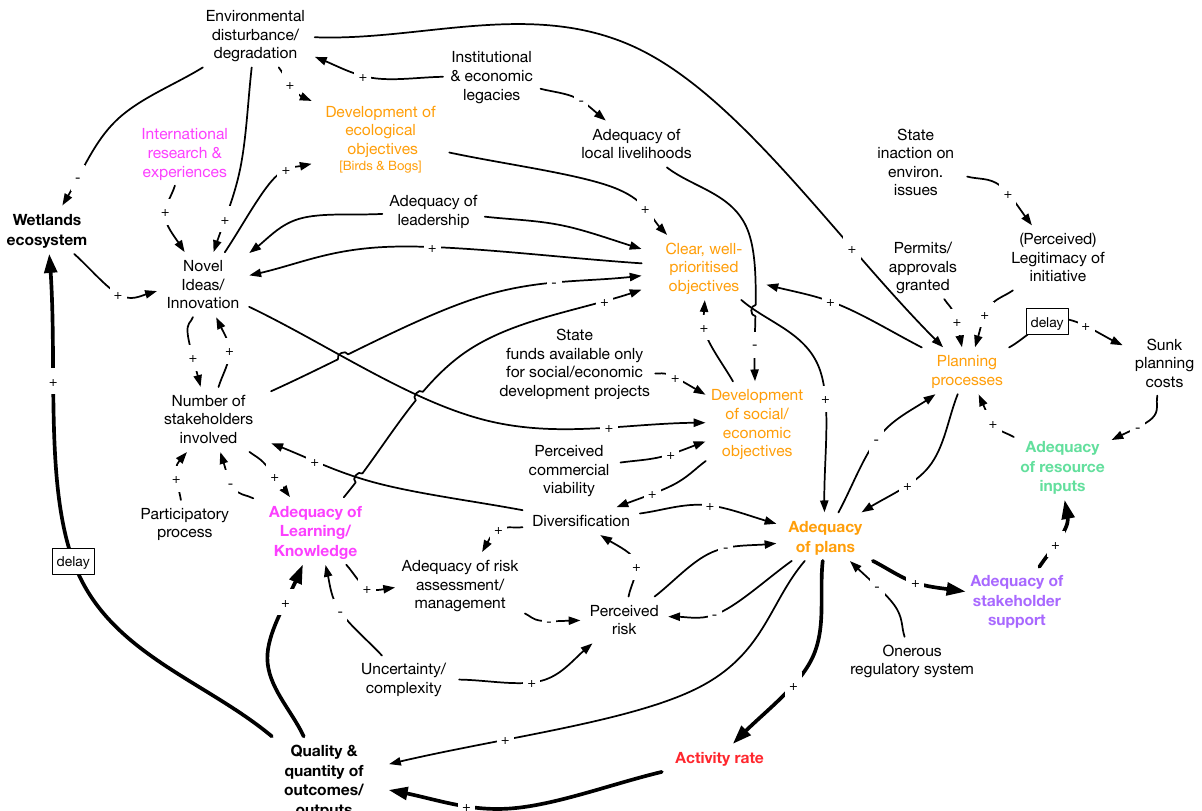
Figure 5 (from main paper). Sub-model unpacking the causal dynamics influencing the Adequacy of plans for wetland restoration initiatives in Belarus. Core processes are in bold. Coloured non-bolded variables represent specific concepts unpacked from within respective core processes. E.g. Clear, well-prioritised objectives is a facet of Adequacy of plans. Thick lines represent links between core processes. Several variables recur throughout Figures 5-9, representing points where core process dynamics link together in an integrated model 2